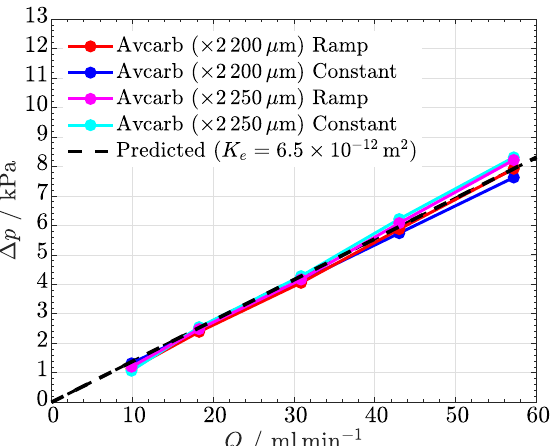
Figure 8. Pressure drop, ∆ p , as a function of the feed flow rate, Q , measured in a VRFB with constant cross-section and ramped interdigitated flow fields, including different AvCarb carbon-paper electrodes. The black dashed line shows the predicted pressure drop across the electrode for K e = 6.5 × 10 − 12 m 2 ( γ ∼ 10 − 2 ).